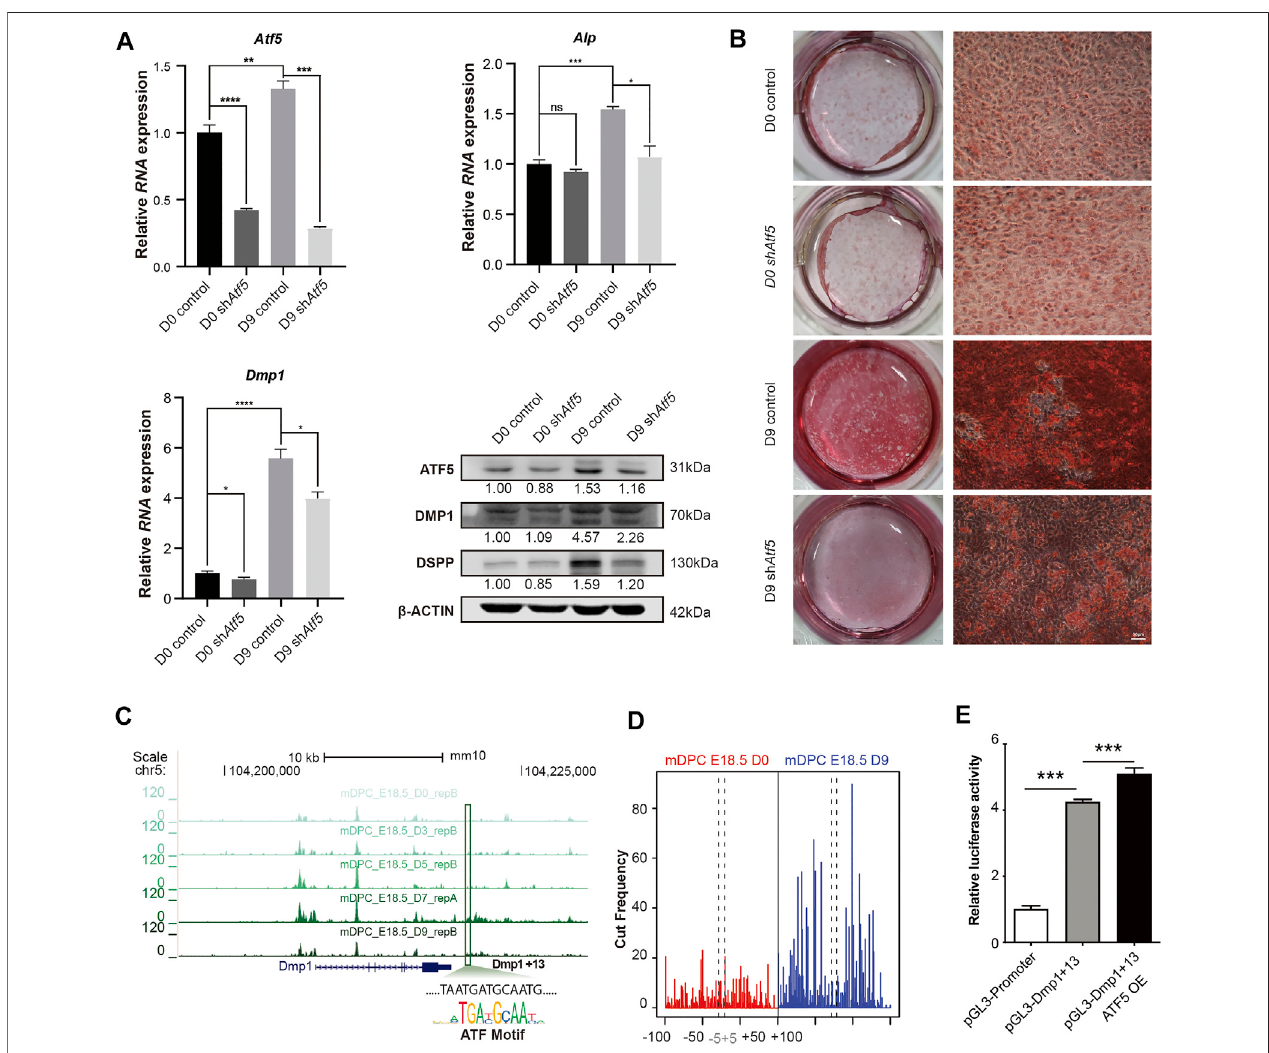
FIGURE 4 | ATF5 promotes odontoblast terminal differentiation by activating a Dmp1 -related enhancer. Primary mDPCs of E18.5 mice cultured in mineralization induction medium for 0 days (D0) and 9 days (D9) after infection with lentivirus-expressing shRNA against Atf5 and empty control. (A) qRT-PCR and Western blot showing expression of related odontoblast markers in different conditions. (B) Alizarin red staining showing fewer mineralization nodules on D9 in sh Atf5 group compared with control. (C) A chromatin region in the downstream of Dmp1 (Dmp1+13) gradually gained accessibility (belonged to cluster 3 in Figure 3 ) in time – course ATAC-seq with a typical binding motif for the ATF family. (D) Tn5-transposase footprint based on CENTIPEDE revealed the ATF-binding motif in (C) “ protected ” on D9 ATAC-seq. (E) Dual-luciferase assay showing the enhancer activity of Dmp1+13 could be promoted by the overexpression of ATF5 in mDPC cells. * p < 0.05, ** p < 0.01, *** p < 0.001.